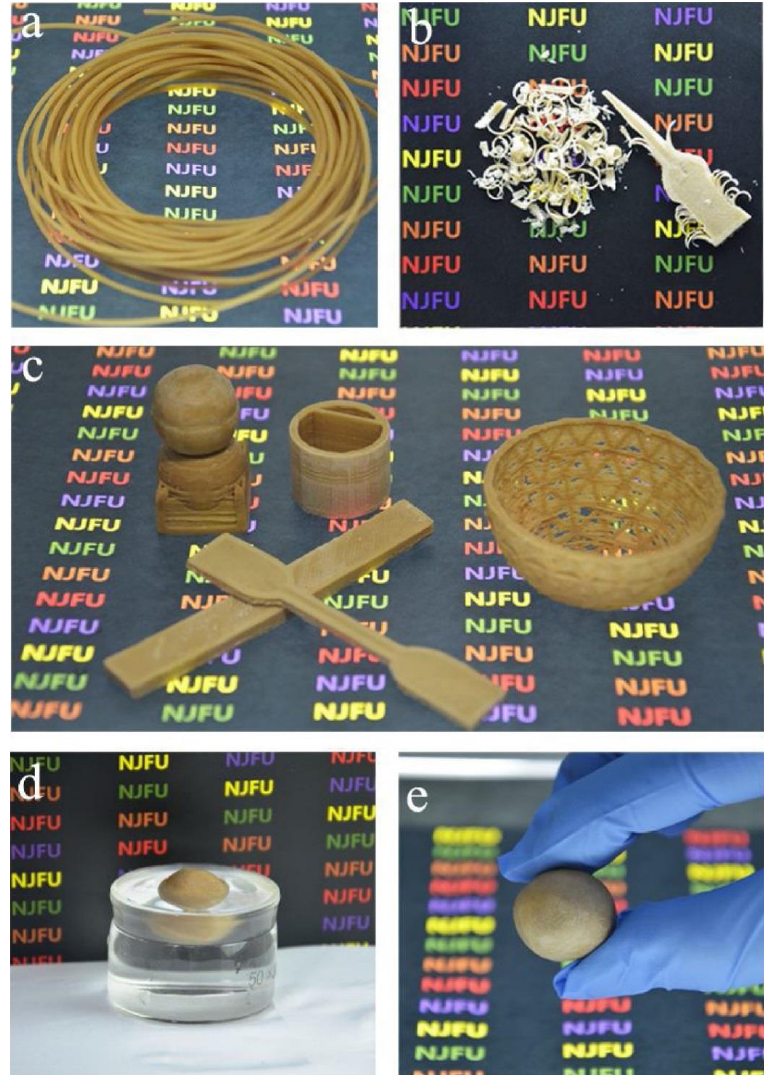
Figure 6. Photos of the 3D printed objects with the MNC/PLA composites: the MNC/PLA composite 3D printing wire rods ( a ); the 3D printed material subjected to planing and sawing ( b ); samples of 3D printed objects, including double-balls standing on the shelf, buckets, half-baskets, and sticks in elongated and dumbbell shape that were used for the testing of mechanical properties ( c ); the 3D printed solid ball floated on the water ( d ); and the 3D printed solid ball with 2 cm diameter ( e ). Reprinted with permission from [86].